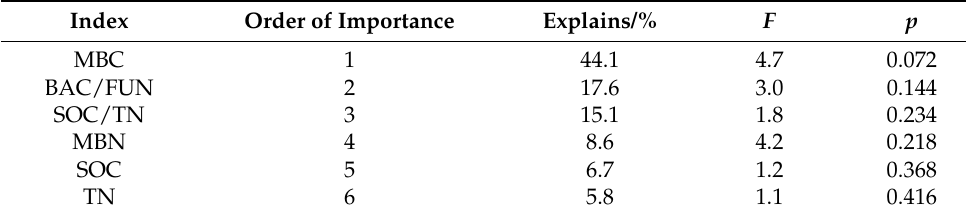
Table 4. Importance sequencing and Duncan’s test of soil